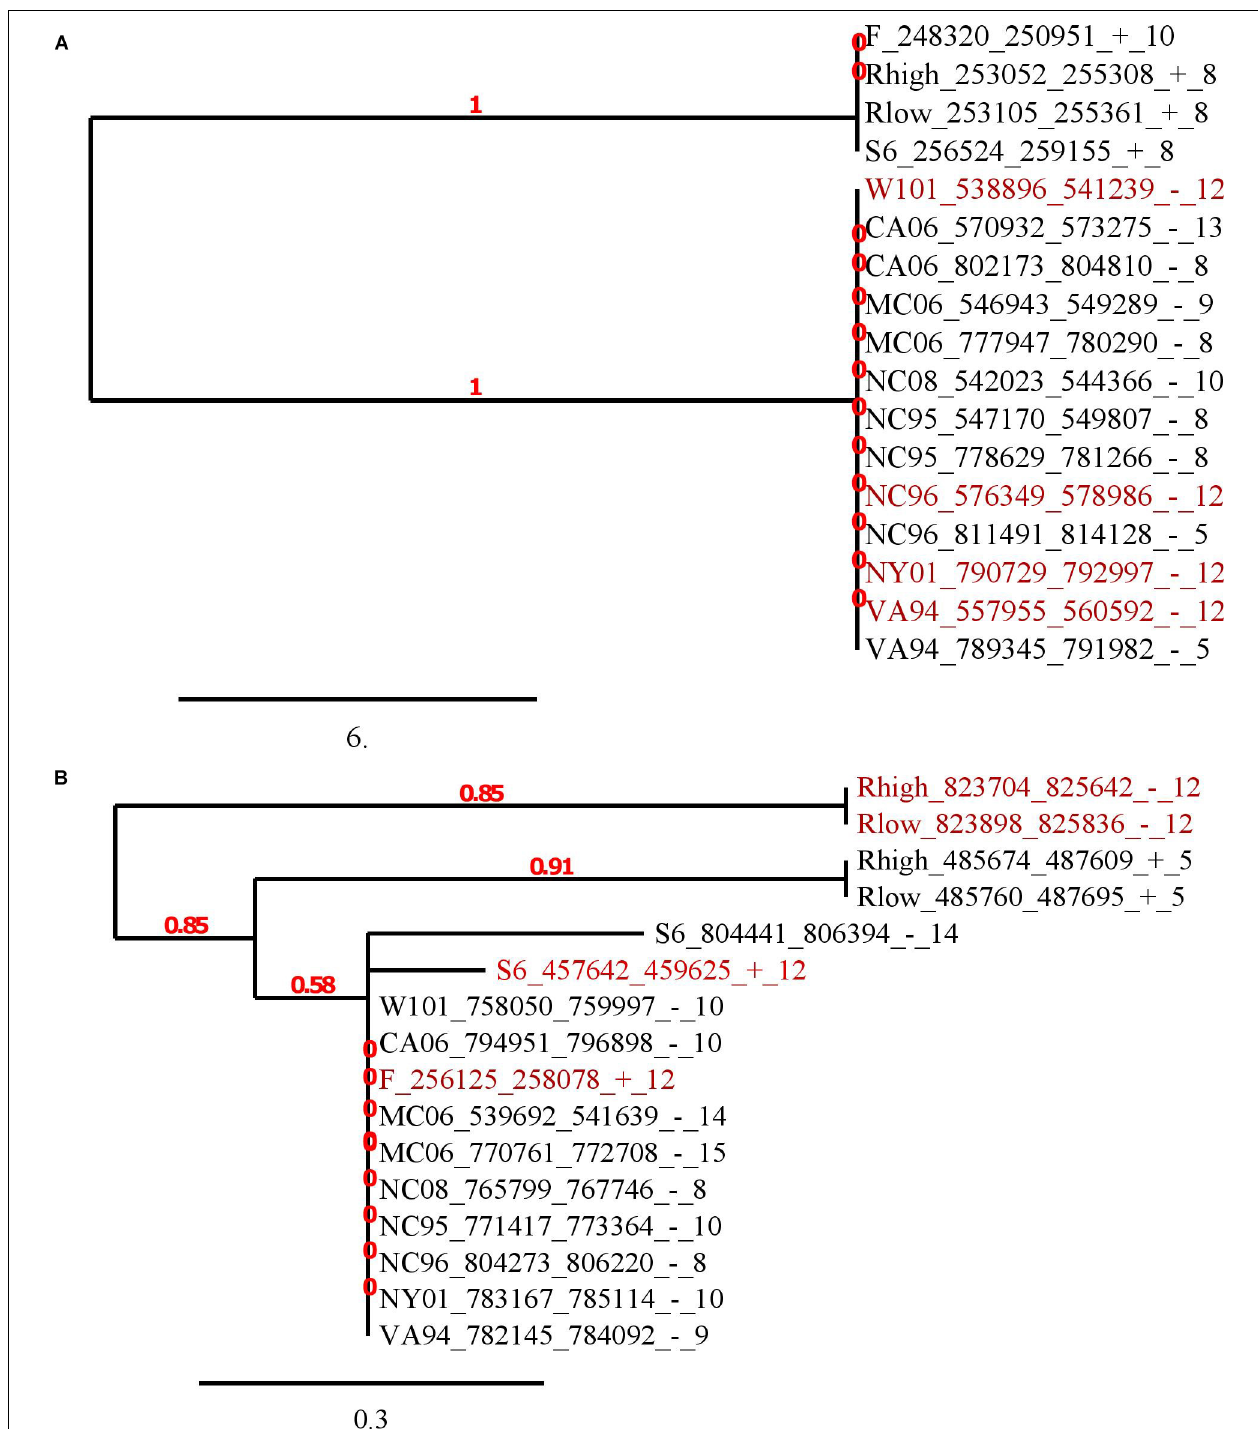
FIGURE 4 | Phylogenetic trees of (GAA)n flanking sequences. The trees were constructed by Phylogeny.fr software based on T-coffee nucleotide alignments of 50 bp flanks. The maximum-likelihood method was applied for phylogeny reconstruction. Labels of sequences consist of strain short name, corresponding vlhA gene position (start, end, strand separated by ‘_’) and GAA units number separated by ‘_’. Red color shows 12-GAA promoters. The scale bar shows 0.02 changes. Red numbers on branches display branch support values. (A) The tree of the biggest orthologous group that is depicted in the last column in Figure 3A ; (B) the tree of another orthologous group, consisting of four 12-GAA genes. The group is depicted in 41 column in Figure 3A .